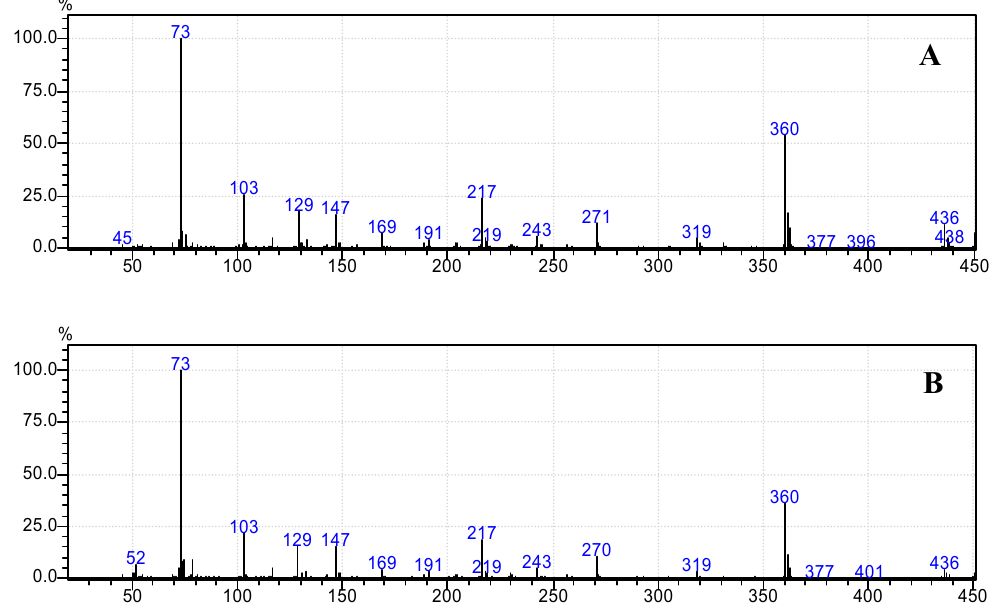
Figure 9. Mass spectrum at a retention time of 3.99 min. ( A ) Standard D -glucose; ( B ) Date juice.